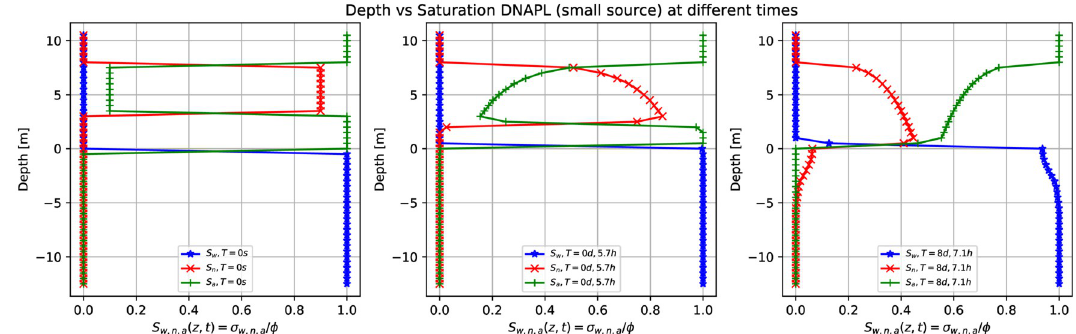
Fig 9. Depth vs. saturation of DNAPL (small source) at different times. Three-dimensional numerical simulation results of a depth as a function of the water saturation S w (blue points), DNAPL saturation S n (red points), and air saturation S a (green points) (plane x = 0) at various times for a small leak of DNAPL of Fig 8. Initially, at t = 0 s , there is a sharp front of contaminant saturation (red points) situated in the unsaturated zone at z = [4.0, 7.0] m. The unsaturated zone comprises the contaminant and air (green points). Later, the contaminant starts to move downward, and the saturation starts to decrease in the unsaturated zone (center). Contextually, the air phase begins to occupy the space left by the contaminant (green points). Finally, (left-hand side) the contaminant arrives at the groundwater table and enters the saturated zone (see also Fig 8, same